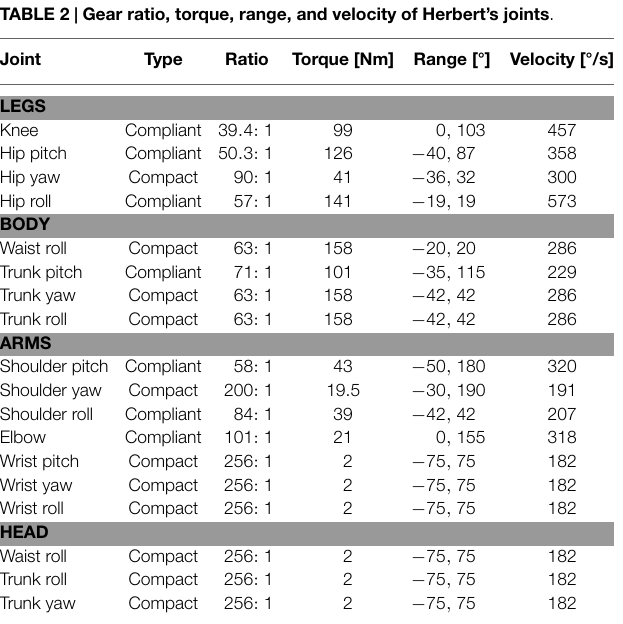
TABLE 2 | Gear ratio, torque, range, and velocity of Herbert’s joints